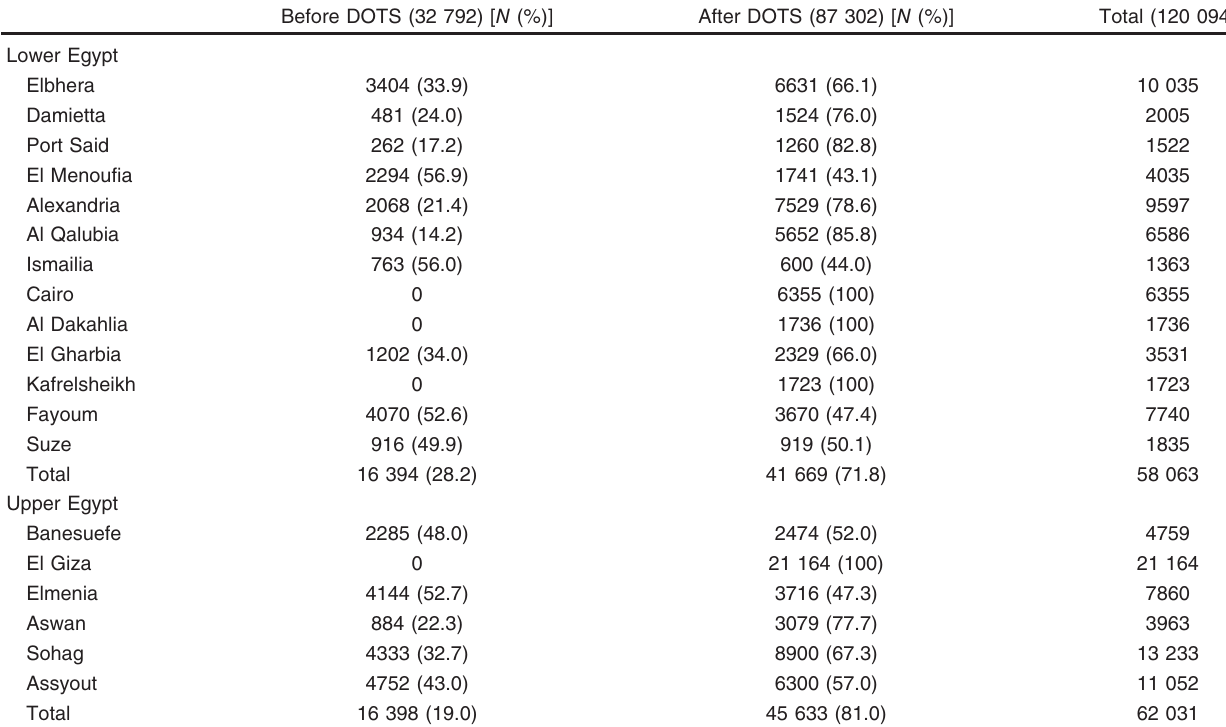
Table 1 Spatial distribution of cases of tuberculosis infection before and after application of directly observed treatment short- course strategy Before DOTS (32 792) [ N